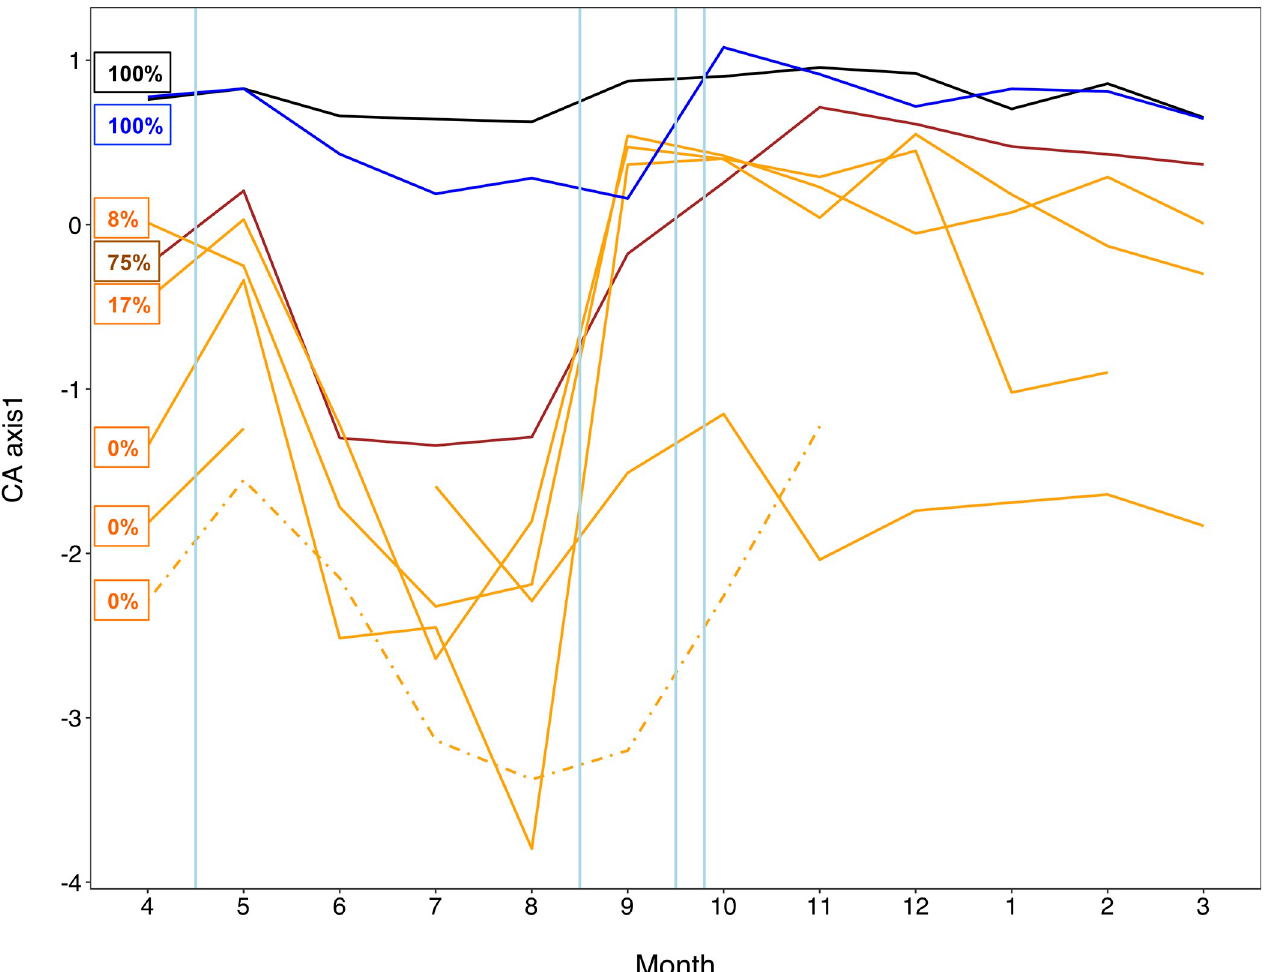
Fig 6. Temporal changes in community composition. Correspondence Analysis (CA) axis scores for each floodplain waterbody over the hydrologic year. The colour code follows the gradient of lateral hydrologic connectivity (%) indicated in the text boxes. Black and blue lines represent the main and side channel, respectively. The brown line indicates backwater, while the others, mostly isolated, waterbodies are shown in orange. The dashed line indicates the ephemeral pond. The ephemeral channel, inundated for only three months, is not shown. Vertical blue lines indicate the occurrence of bankful floods. Temporal patterns show that the composition of the floodplain waterbodies tended to converge (towards a ‘main channel’ condition) after the floods, but to diverge during months of stable hydrologic conditions, reflecting differential species sorting.